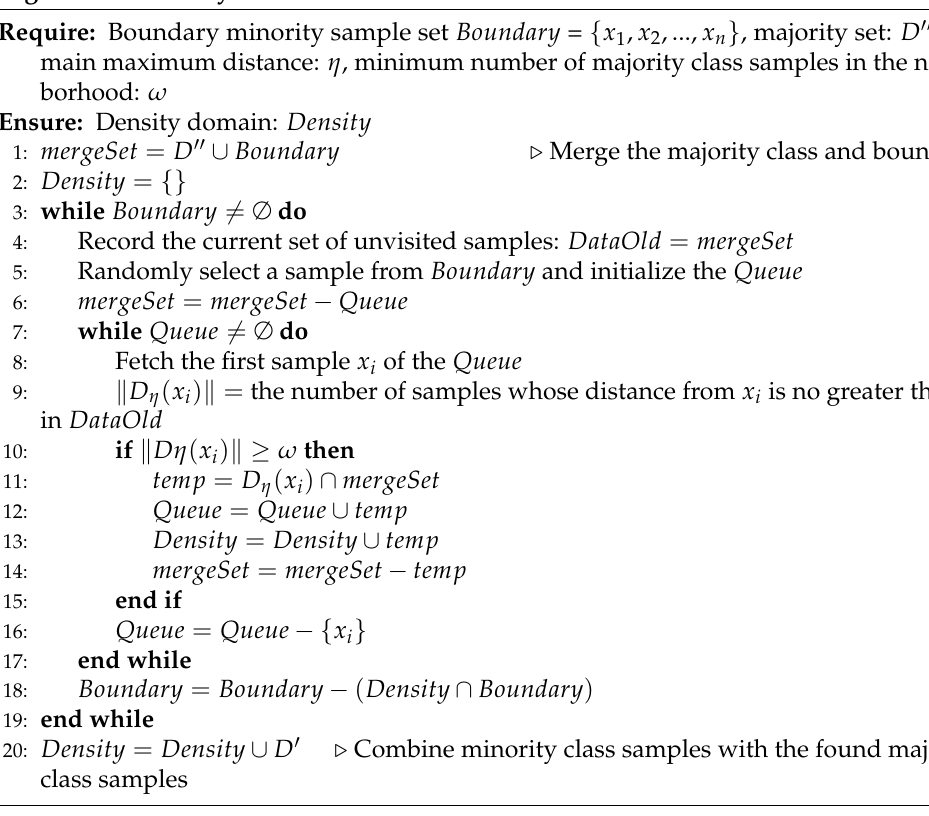
Algorithm 4 Density domain